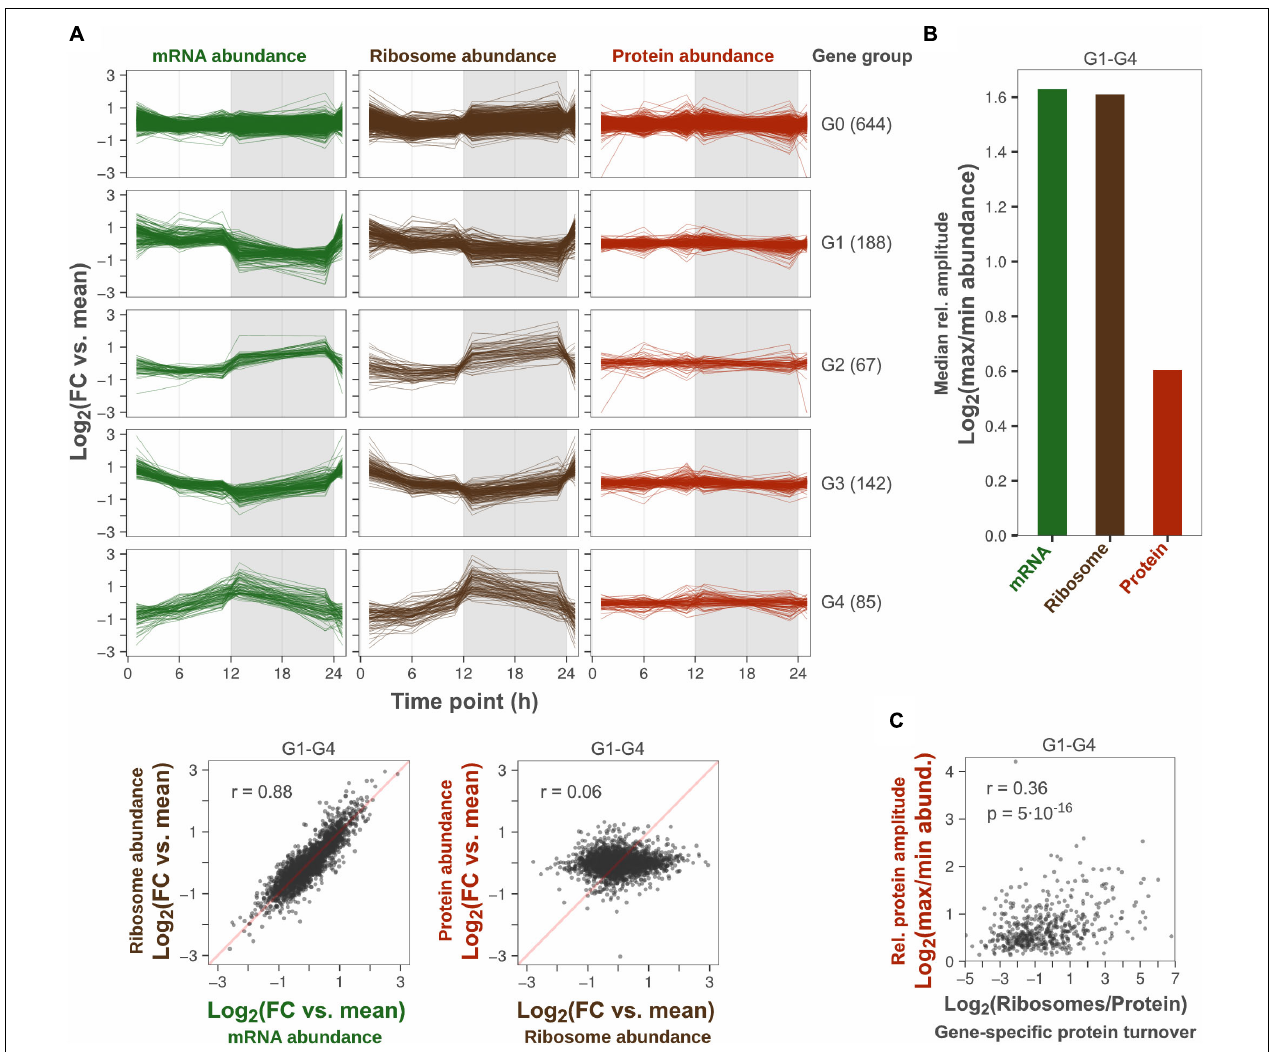
FIGURE 1 | Protein amplitudes over a diurnal cycle are small relative to amplitudes in transcription and translation. (A) Comparison of diurnal expression patterns at the level of transcription, translation and protein. The log 2 -transformed fold change (FC) vs. the daily average gene-specific abundance of mRNA, ribosome and protein was plotted for each gene detected across all three levels (top). Time point 1 was plotted twice to visualize changes at sunrise. Genes were grouped according to their daily mRNA abundance pattern: No significant change (G0), Cyclic (G1–G4). The number of genes in each group is shown in parentheses. Scatter plots show the correlation of diurnal abundance patterns between levels among cyclic genes (bottom). Insets show the Pearson correlation coefficient. Duplicate measurements were performed at all time points, except 1 h after sunrise where ribosome abundance was measured in triplicates. (B) Comparison of the median peak-to-peak relative amplitude among cyclic genes. (C) Correlation of relative protein amplitude vs. protein synthesis to protein abundance ratio (inferred gene-specific protein turnover) among cyclic genes. The protein synthesis to protein abundance ratio was based on the daily average abundance of ribosomes and protein. Insets show the Pearson correlation coefficient ( r ) and the statistical significance of the trend ( p